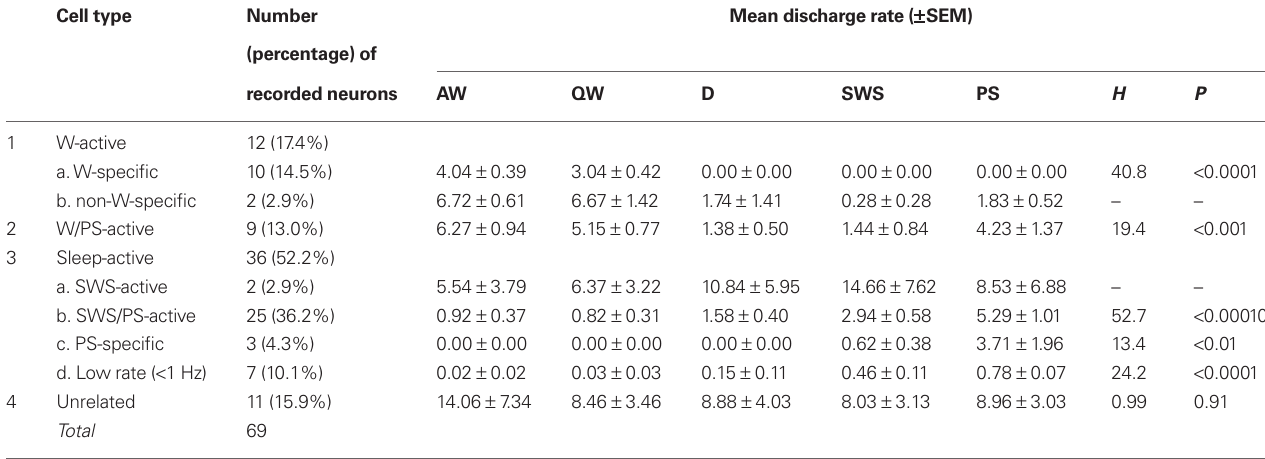
Table 2 | Cell counts and mean discharge rates during the sleep-waking cycle of state-dependent and state-unrelated ventral tuberomammillary neurons in histidine decarboxylase knock-out